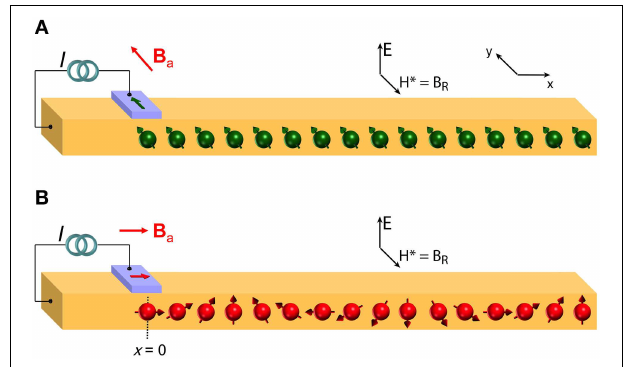
FIGURE 3 | (A) A narrow 2DEG channel extends along the x axis and has − spin polarizing FM injector (purple rectangle). In the nonlocal geometry, a fraction of the injected electrons have ballistic trajectories along x . There is +ˆ no gate voltage, but an intrinsic electric field E results as a spin orbit effect associated with an asymmetry in the confining potential. A strong Rashba spin orbit interaction results in an effective magnetic field H ∗ B R ( y ) for electrons −ˆ = moving with Fermi velocity, v F , x . When an external field B a sets the injector magnetization to be along y , the injected electrons have spin orientation along ˆ y (green spheres). There is no torque from B R and the electrons retain their ˆ spin orientation all along the trajectory. (B) When the external field B a sets the injector magnetization to be along x , the injected spin orientation is along x and ˆ ˆ the spin moment of the electron (red spheres) precesses along its